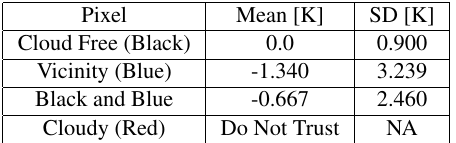
Table 6: Expected means and standard deviations for each cat- egory included with the additional confidence metric band after bias correction for cloud free